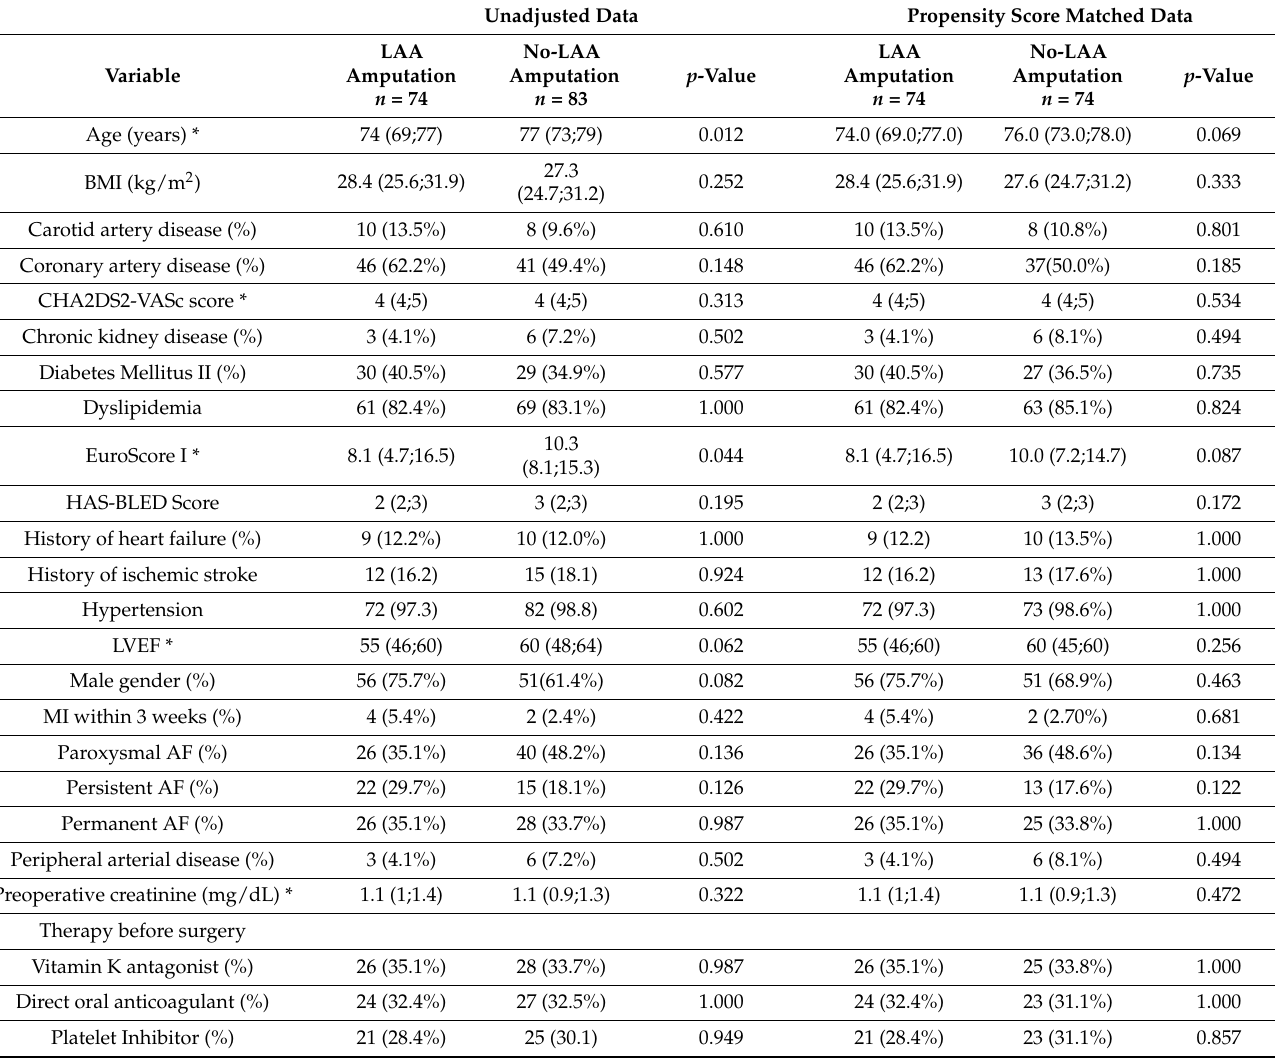
Table 1. Preoperative profile of 157 unmatched and 148 matched patients with LAA